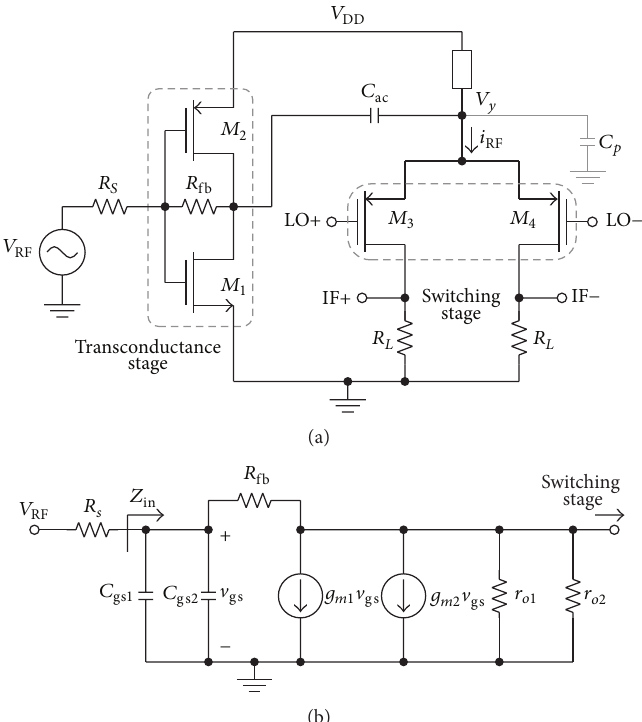
Figure 1: (a) Simplified single-balanced RFCR mixer and (b) small signal equivalent circuit of RFCR transconductance stage.